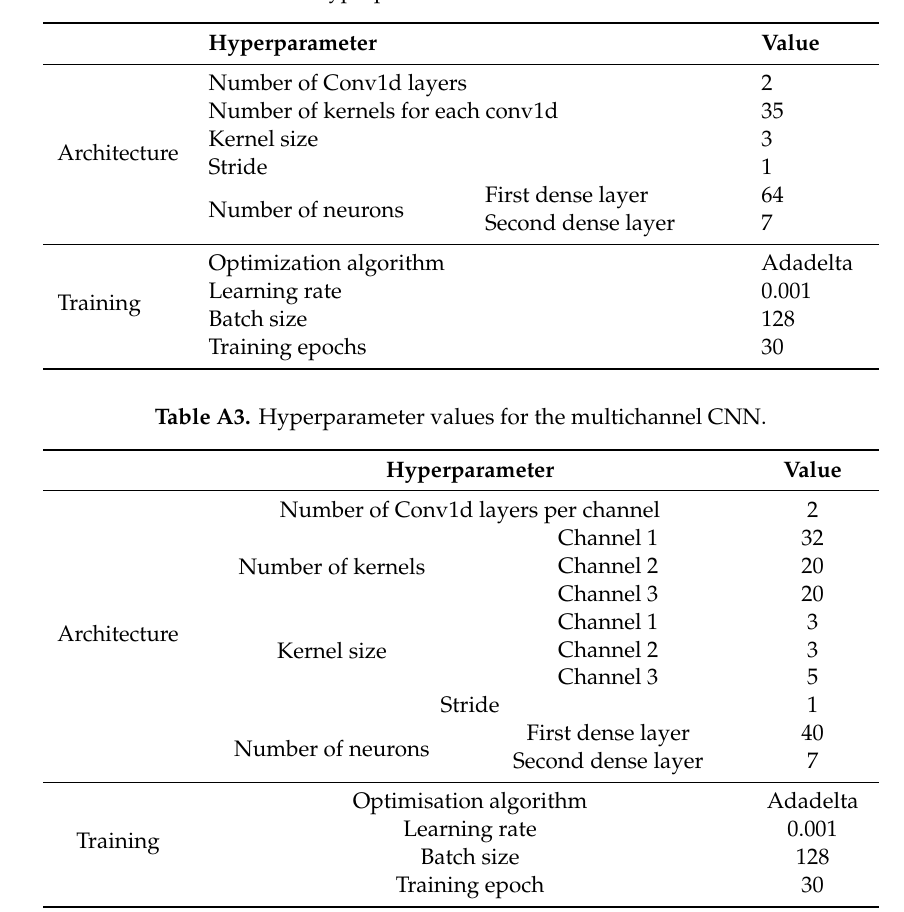
Table A2. Hyperparameter values for the 1D CNN.